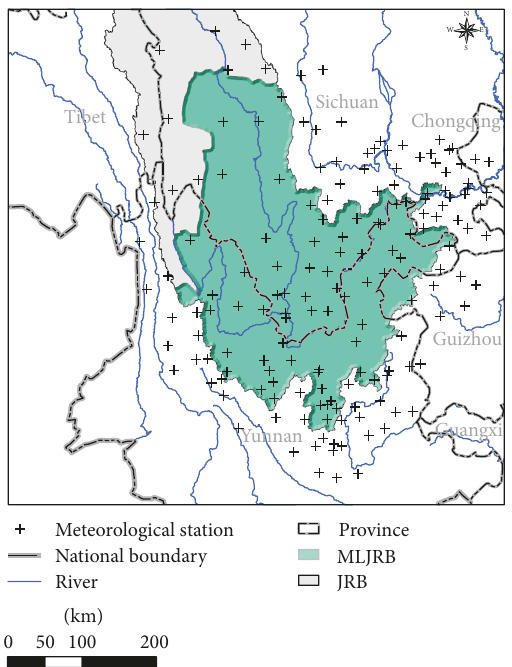
Figure 3: Meteorological stations used in MLJRB.